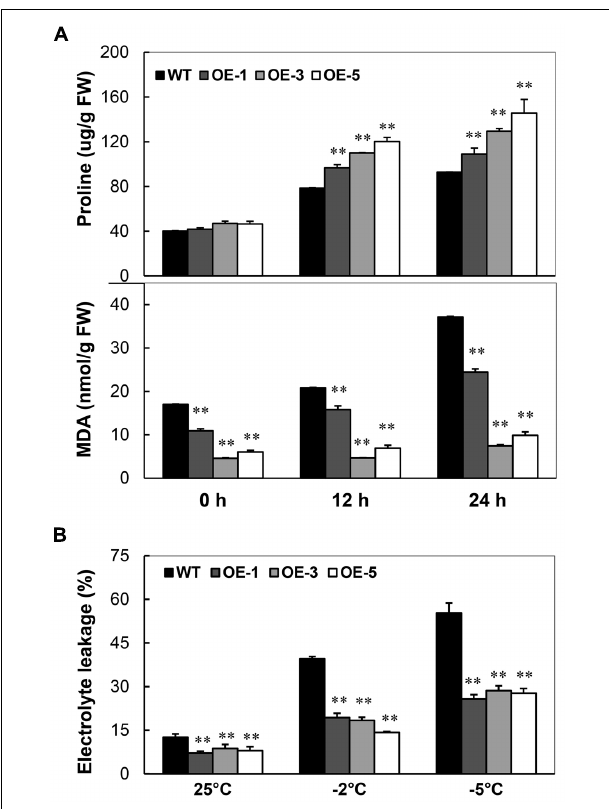
FIGURE 4 | Changes of proline content, MDA level, and electrolyte leakage in Arabidopsis CBF3 overexpressing cassava. (A) Proline concentration and MDA level in the WT and transgenic OE plants under cold treatment ( − 2 ◦ C) for 0, 12, and 24 h. FW, fresh weight. (B) Electrolyte leakage of WT and OE plants before and after cold treatment ( − 2 and − 5 ◦ C) for 12 h. Data are presented as mean ± SD of three independent assays; asterisks indicate significant differences compared with the WT at ∗∗ P < 0.01 by Student’s t -test.